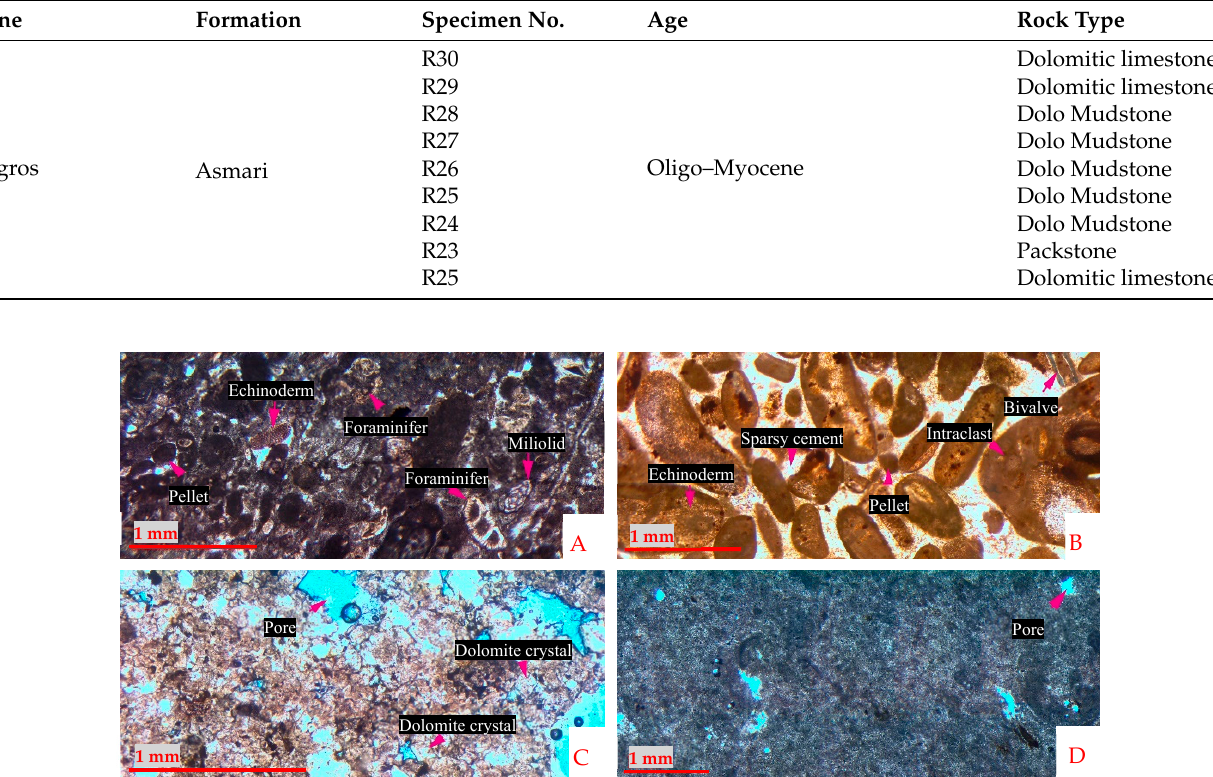
Figure 2. Some photomicrographs of the studied samples: Packstone- R23 ( A ), Grainstone- R13 ( B ), Dolostone- R16 ( C ), and Dolo Mudstone- R28 ( D ). Table 2. Age, sampling zone, and type of rocks.